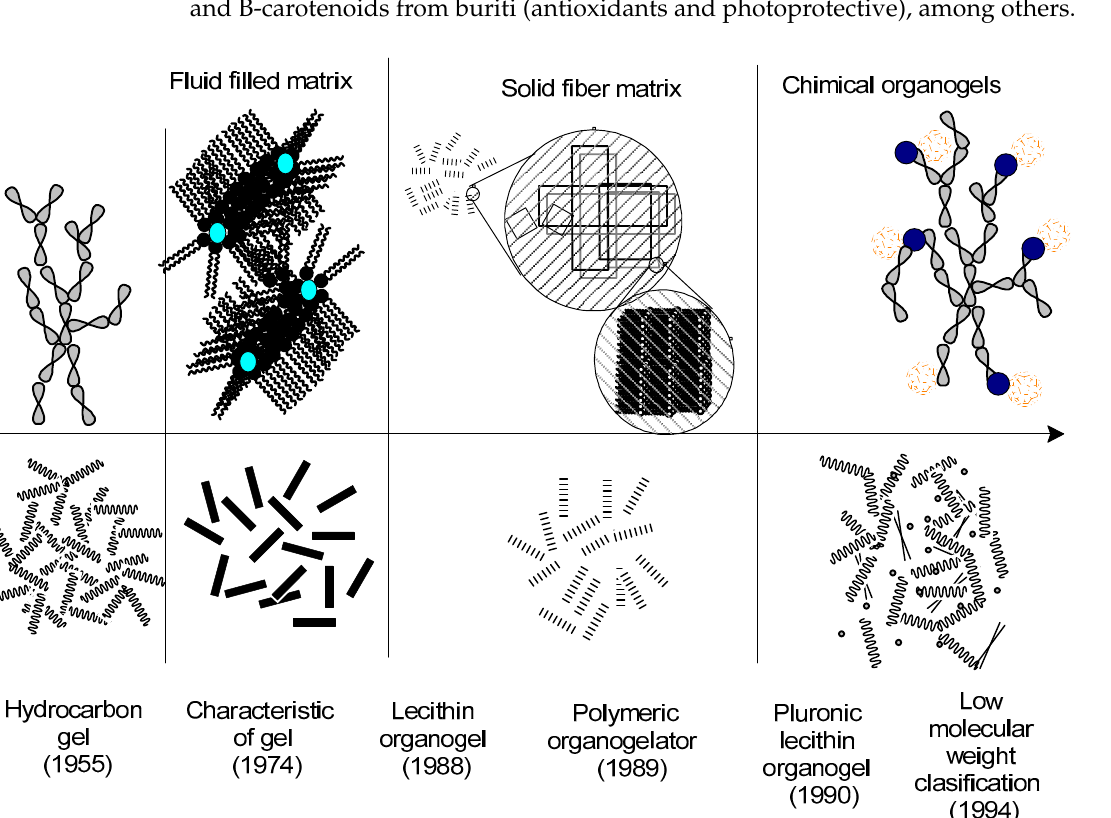
Figure 1. For a long time, gels have evolved in their way of synthesis, especially in the cosmetic area, where the organogels of Lecithin promoted research into the synthesis of new organogels based on polymeric organogelators and low molecular weight. The latter, by its versatility, low cost of synthesis, and high physicochemical stability, is ideal for permeation of bioactives in the deepest layers of the